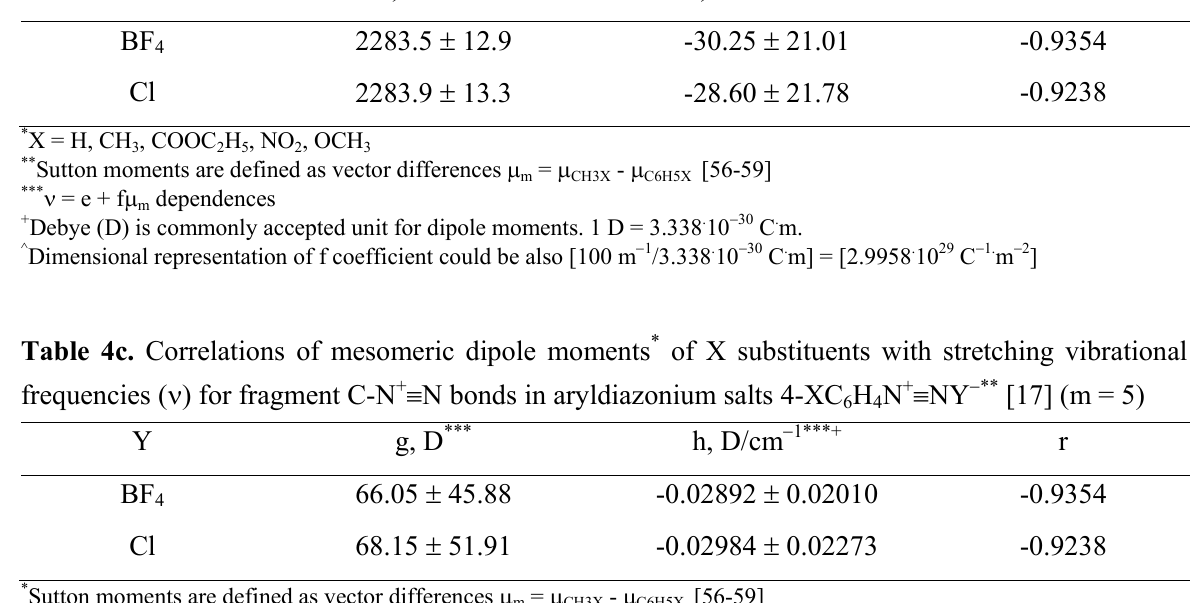
H N + ≡ NY − ** [17] (m = 6 4